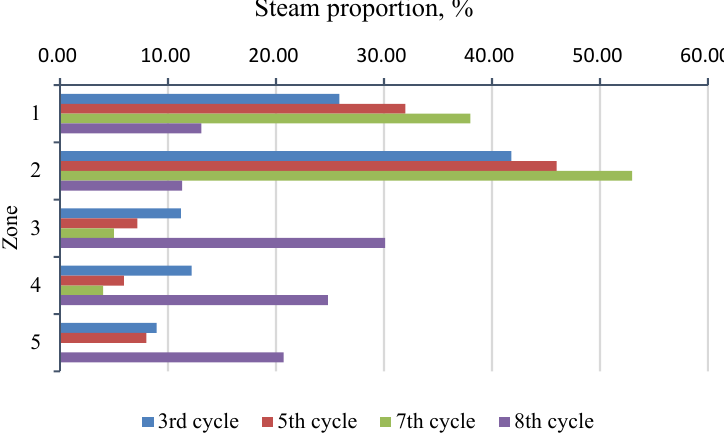
Figure 10. Steam proportion profile at different cycles.